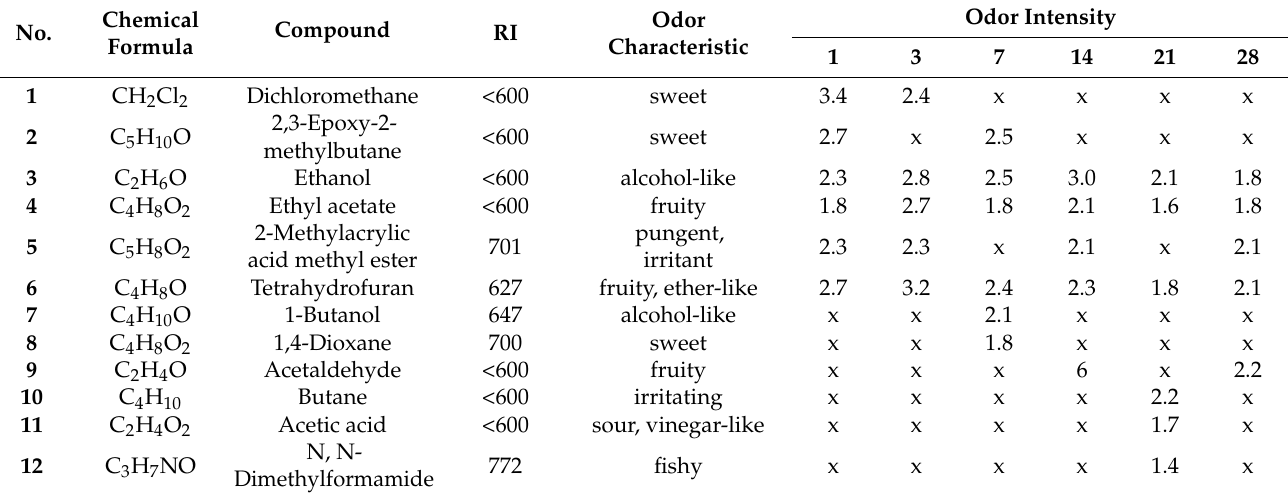
Table 2. The odor characteristics and intensity levels of